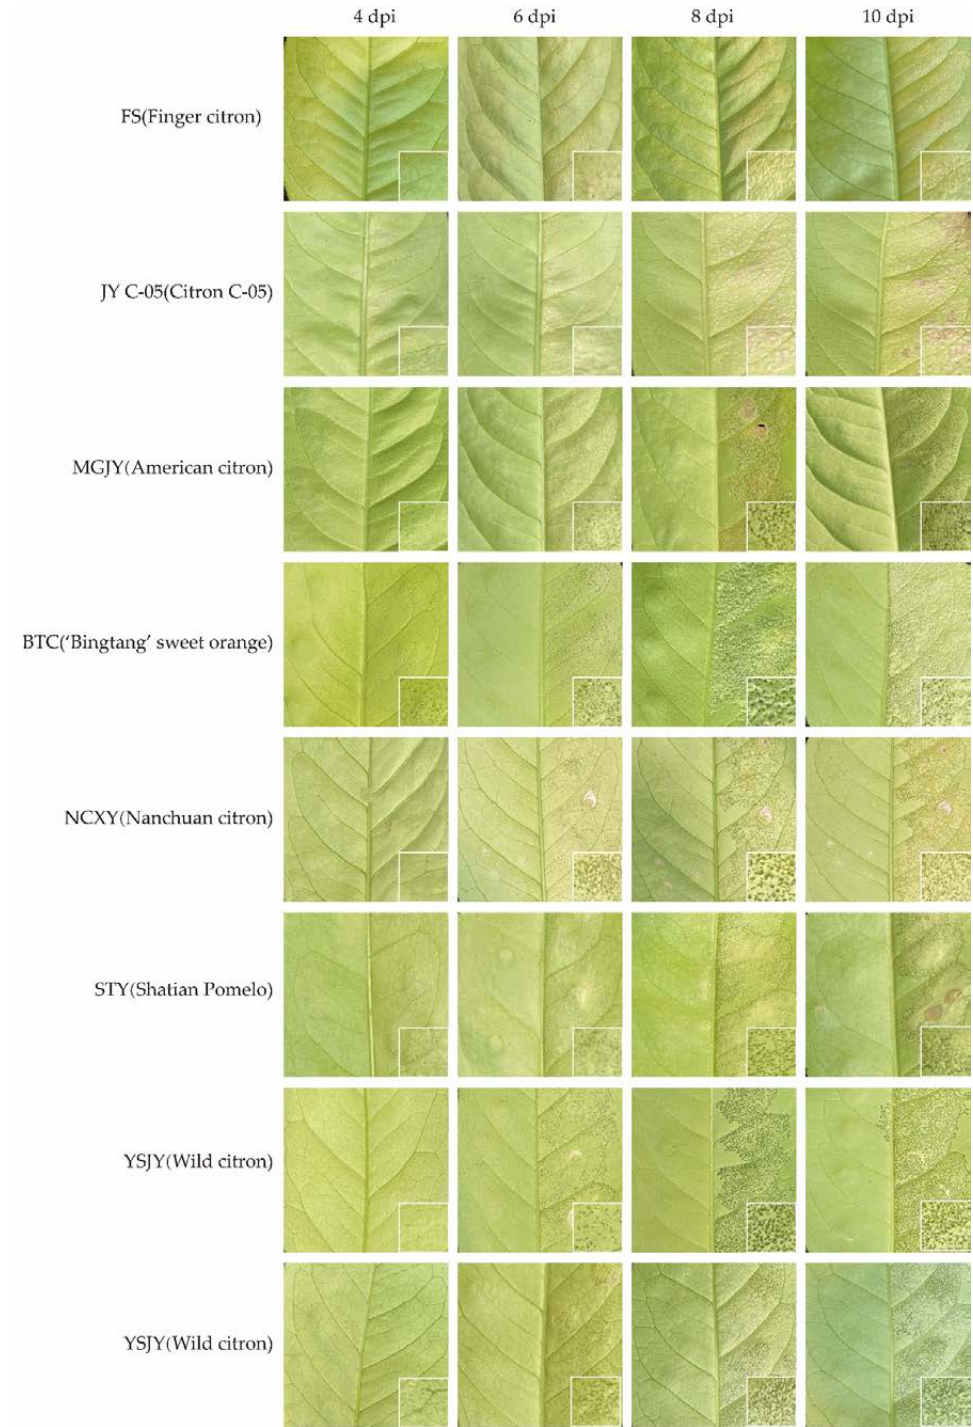
Figure 1. Leaf symptom development of tested citrus cultivars following inoculation with Xcc . Citron C-05, American Citron, Nanchuan Citron, Round citron, sugar orange, Shatian pomelo, and wild citron. Citron fully expanded young leaves were infiltrated with 10 5 cfu/mL of Xcc on the left of the main vein and with the same concentration of Xoo on the right. Symptoms were observed at 2, 4, 6, 8, and 10